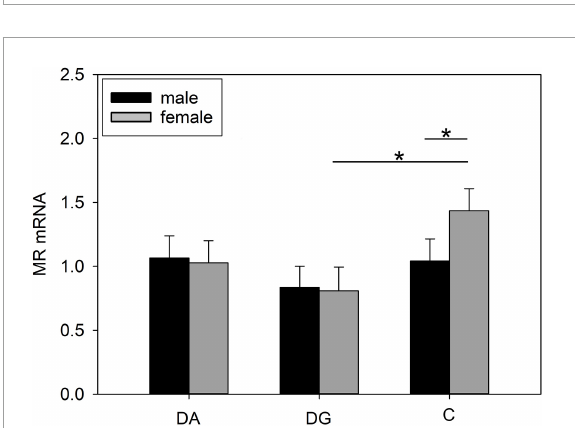
FIGURE6 Gene expression in the amygdala of piglets on PND 20. MR (mineralocorticoid receptor; NR3C2) mRNA expression of DA (deprivation alone), DG (deprivation with a group of littermates), and C (control, no deprivation) piglets. Data are expressed as arbitrary units after normalization to ACTB and TBP mRNA expression as endogenous reference genes and represent the LS means ± SE. Significant differences are indicated by asterisks (* p < 0.05; Tukey-Kramer test; n = 10 per treatment group and